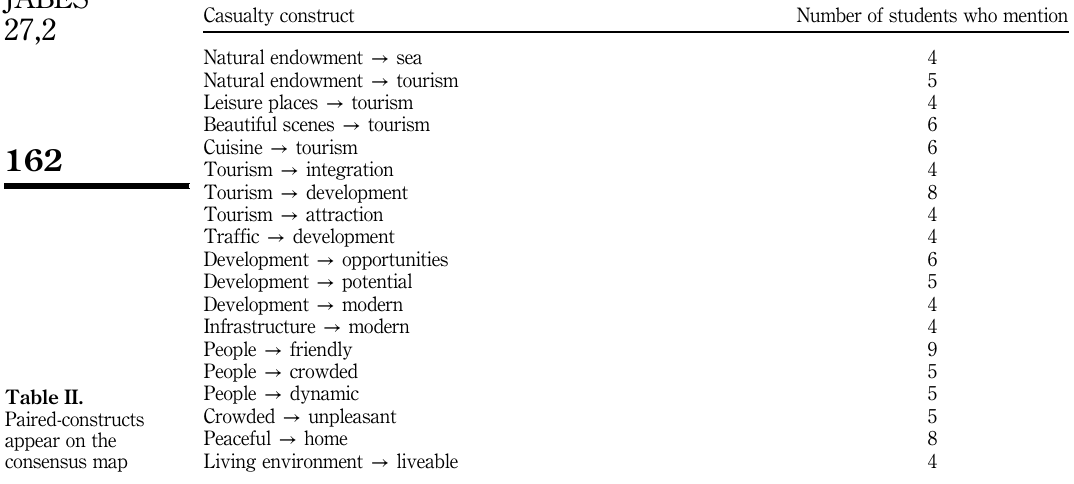
Table II. Paired-constructs appear on the consensus map